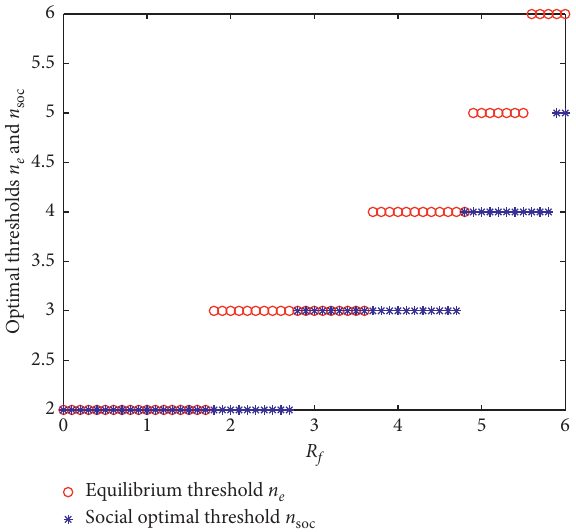
Figure 1: Equilibrium and social optimal thresholds versus R ( C � 3 , R � 7 ) s